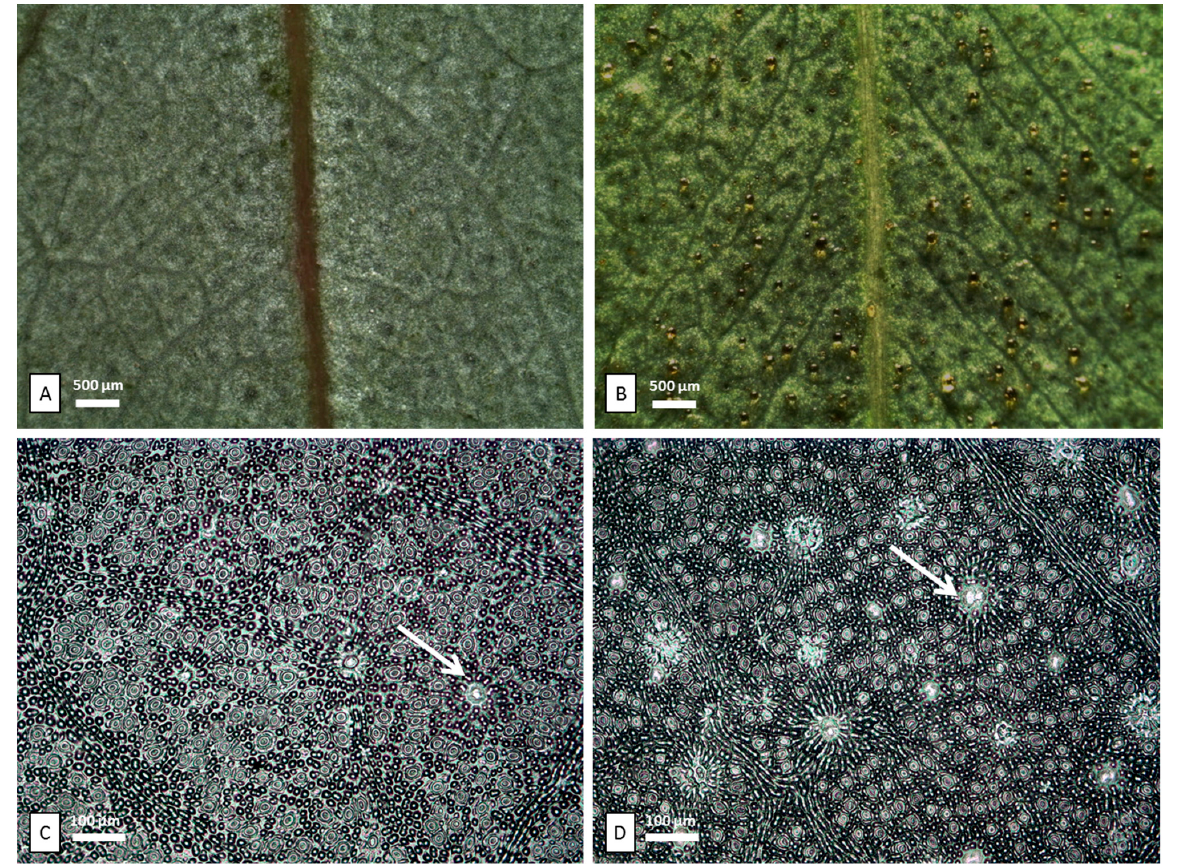
Figure 1. Stereomicroscopy: abaxial surfaces of E. cinerea ( A ) and of E. nicholii ( B ). Light microscopy: leaf epidermal peelings obtained via the nail polish technique from abaxial surfaces of E. cinerea ( C ) and of E. nicholii ( D ). White arrows show the overlying cells covering the secretory cavities.